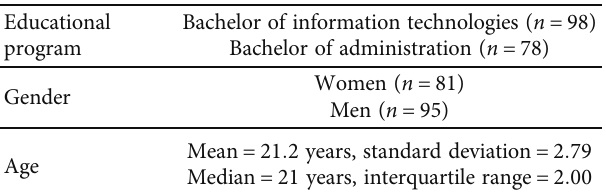
Table 3: Participant